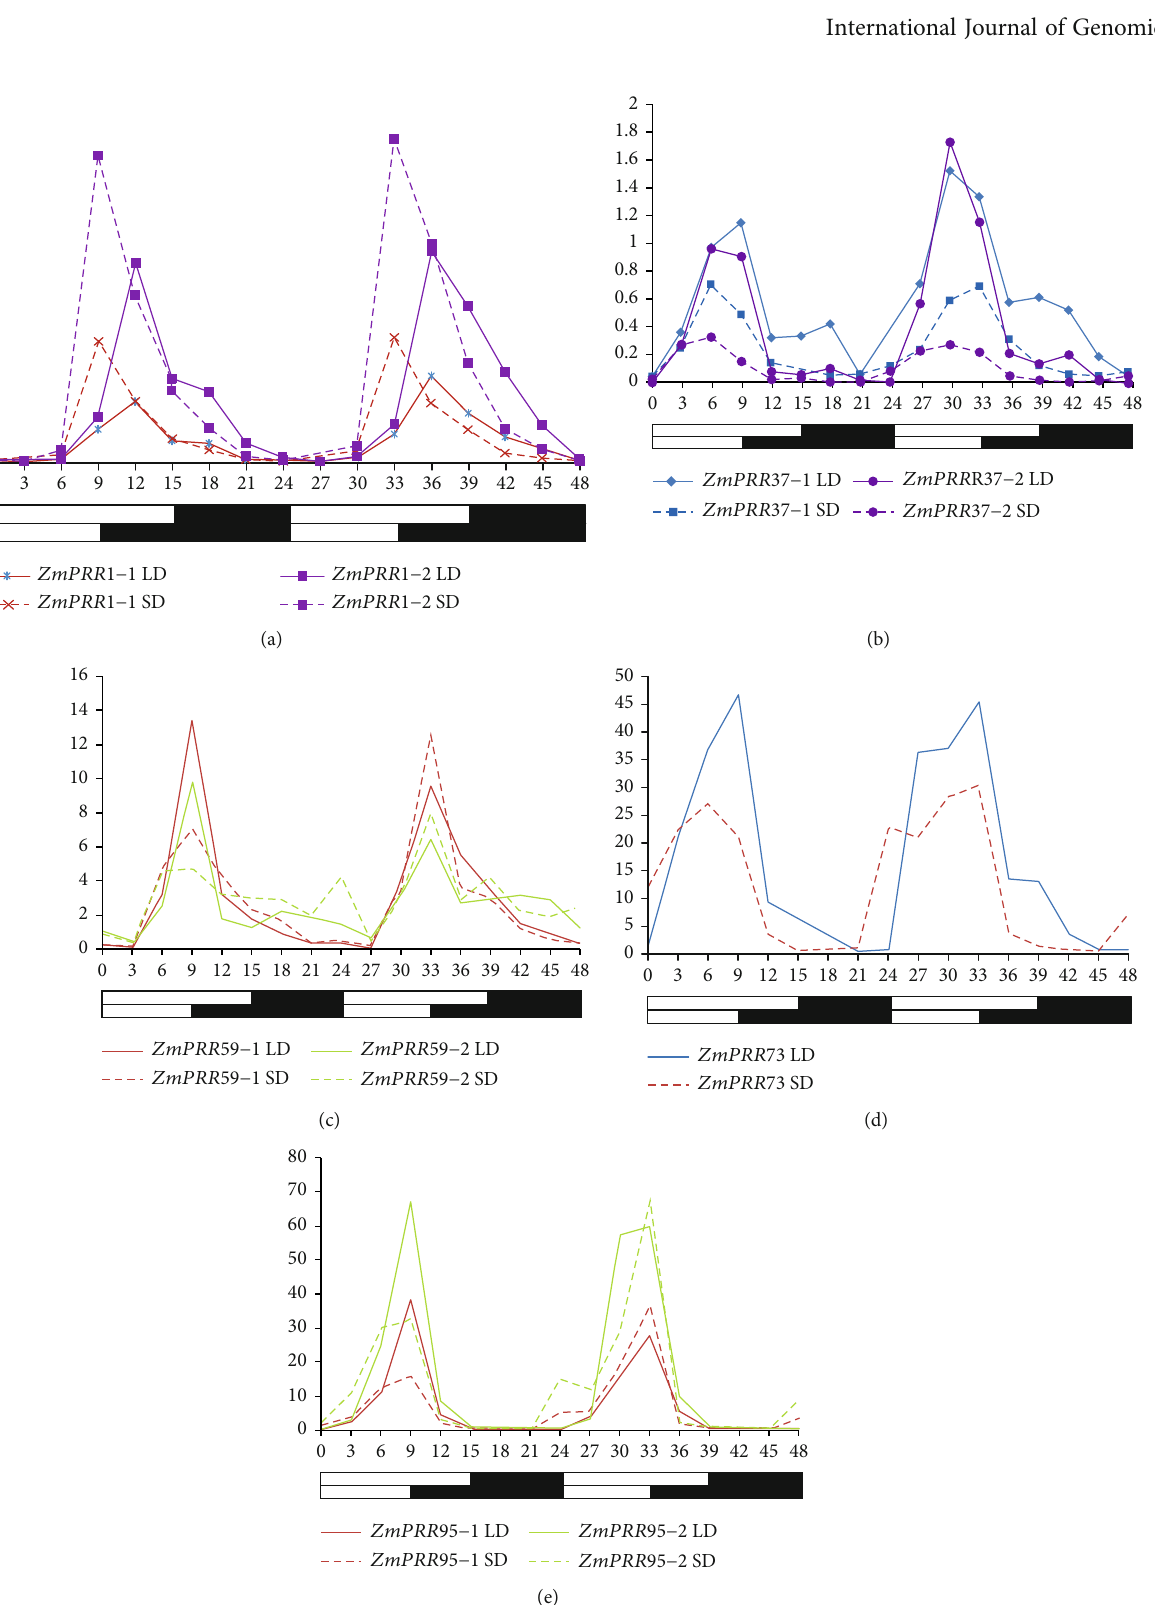
Figure 6: Expression pattern of ZmPRRs under diurnal changes. Expression levels of ZmPRRs in leaves of CML288 throughout a 48-h period of LD or SD treatment. The relative expression levels are normalized to ZmUBQ . The data are means ± SE of three biological